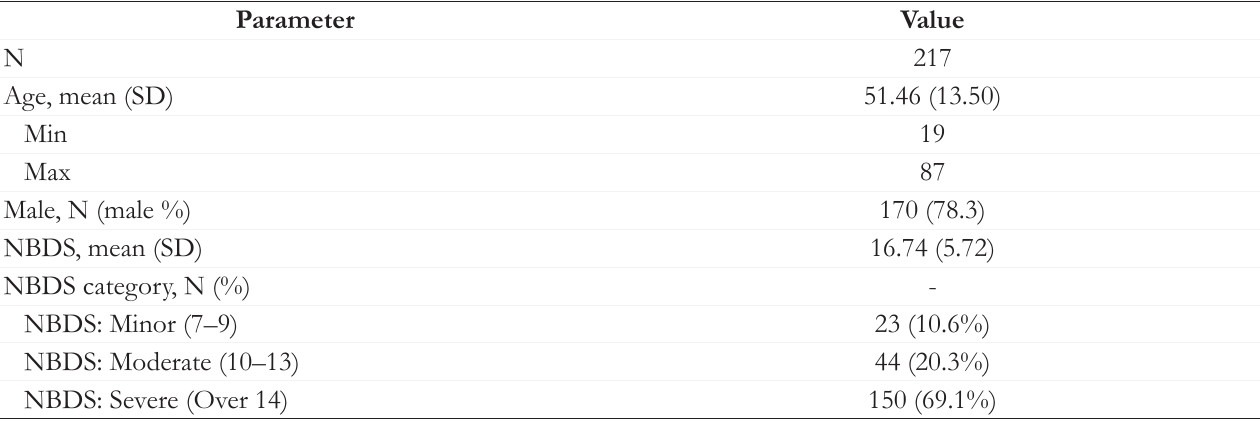
Table 1. Characteristics of Patients who Answered the Questionnaire and Included in the